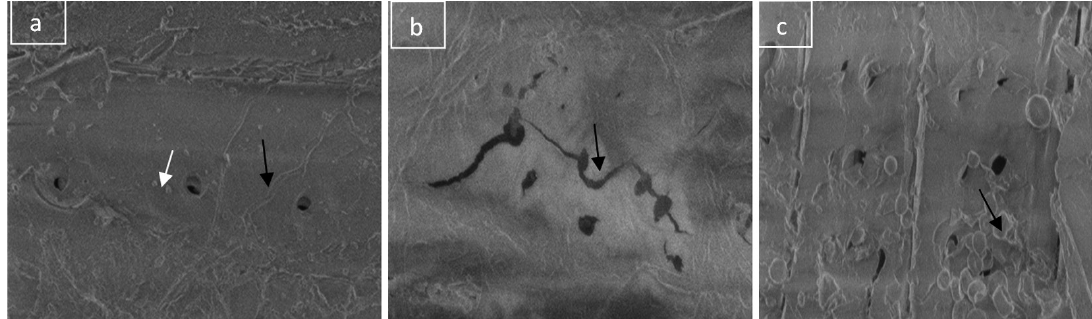
Figure 4. Photomicrographs obtained by SEM for the autoclaved wood samples evidencing the presence of: a) hyphae, open pores, and residues of oleoresin capsicum; b) cracks after fungal attack; c)